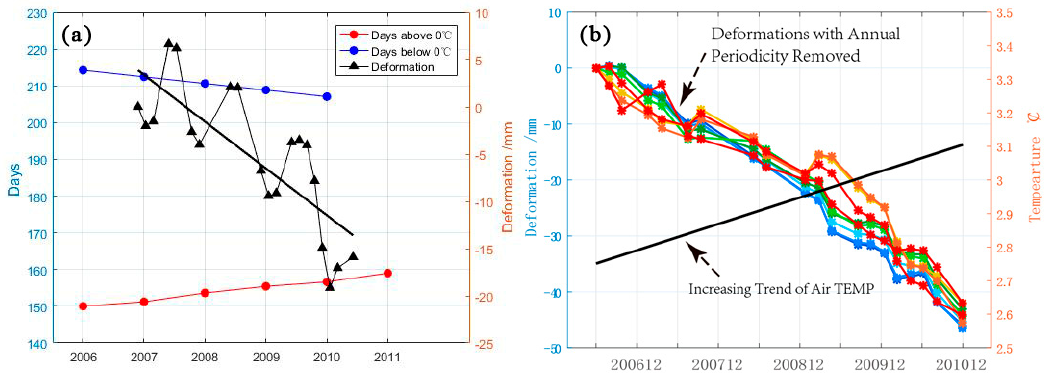
Figure 10. ( a ) the deformation of area P1 and the period of below/above 0 °C ; ( b ) linear residual of deformation and fitting linear residual of air temperature.